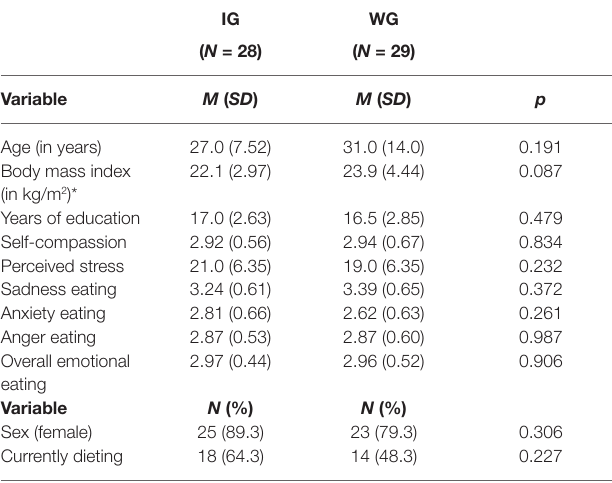
TABLE 1 | Baseline characteristics of the final sample divided by intervention group (IG) and waitlist control group (WG). Values show means ( M ) and standard deviations ( SD ) or number of individuals ( N ) and percentage